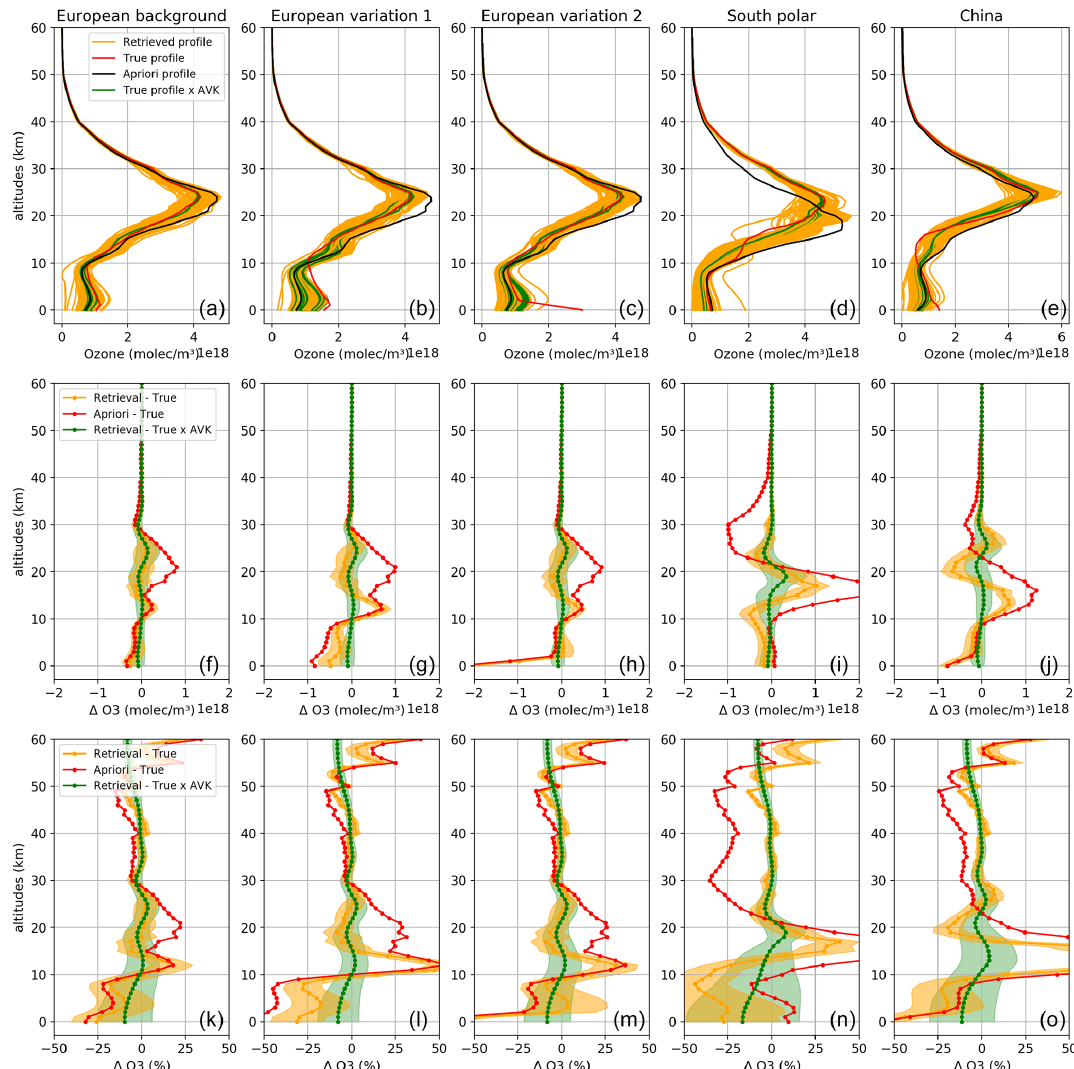
Figure 2. Retrieval results for the five CAMELOT scenarios (true); all settings are listed in Table 2. The upper row, (a–e) , shows the retrieved (orange), a priori (black), and true profiles (red), as well as the true profiles convolved with the averaging kernels (green). The middle and bottom rows present the absolute (f–j) and percentage (k–o) mean differences between the retrieval results and the true profiles (orange), the mean differences between the retrieval results and true profiles convolved with the averaging kernels (green), and the differences between the a priori and true